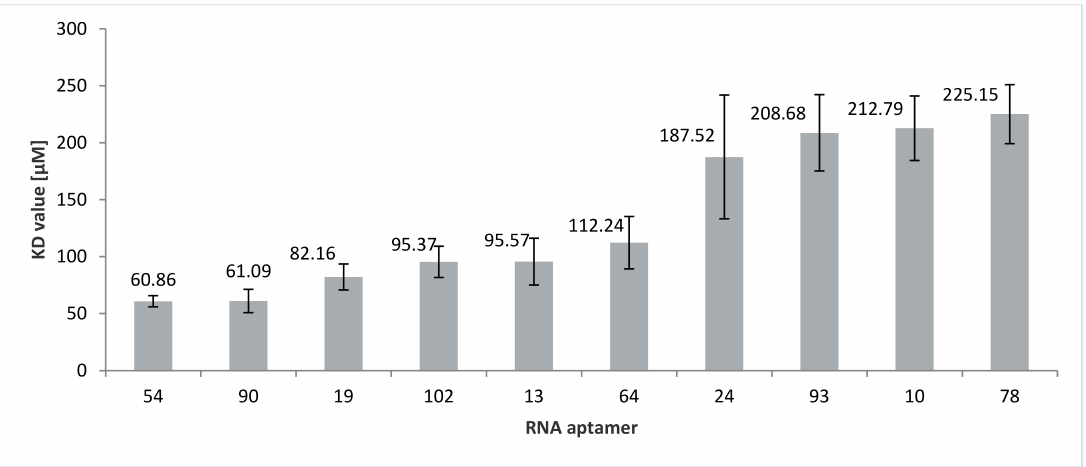
Figure 3. Comparison of the K D values for binding of RNA aptamers to RAFT liposomes. The K D values are the mean ± SE of 3–4 independent